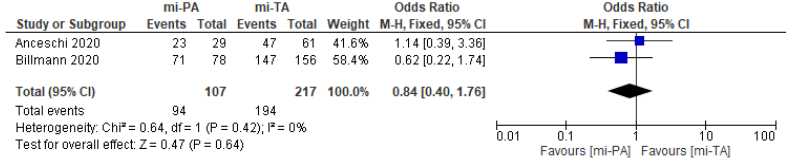
( c ) Forest plot representing analysis of patients with absent clinical success according to PASO criteria.